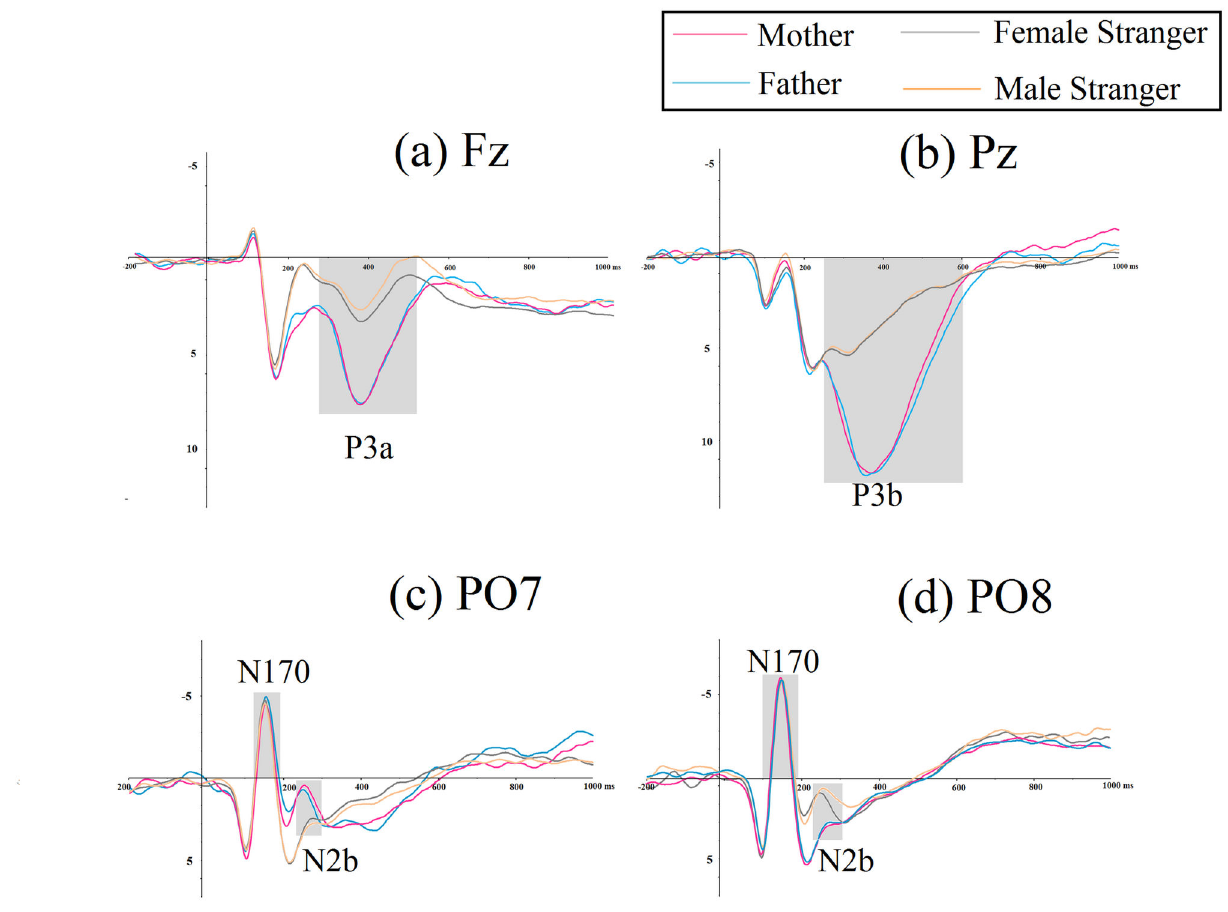
Figure 2. Grand average ERPs evoked by different face types. The light gray shaded areas indicate (a) a 250-550 ms time window for the P3a component at the frontal electrode, (b) a 250-650 ms time window for the P3b component at the parietal electrode, (c) and (d) a 130-180 ms time window for the N170 detection and a 200-300 ms time window for the N2b at the bilateral occipito-temporal